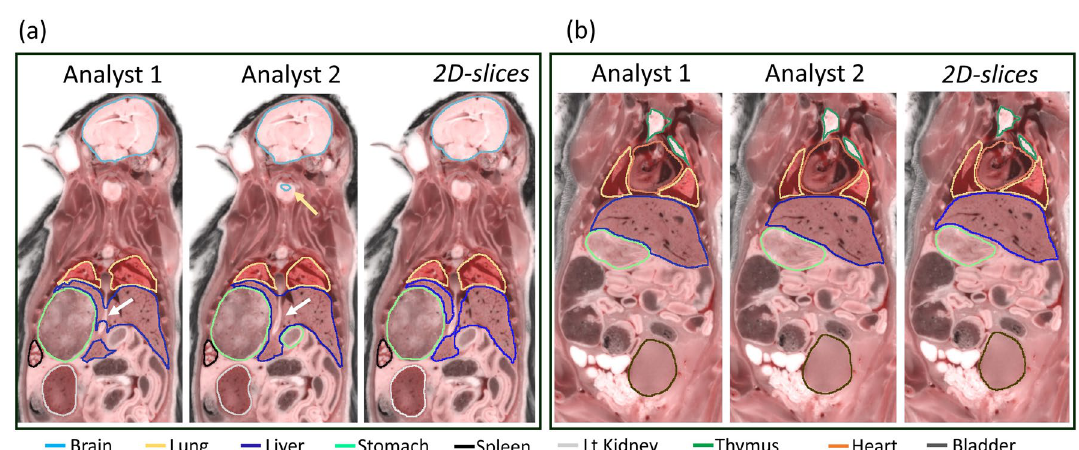
Figure 4. 2D visualization of segmentation results from the 2D-slices model and annotations from Analysts 1 and 2. Both analysts mistakenly included esophageal tissue (white arrows). Analyst 2 mistakenly labeled some spinal cord as brain (yellow arrow in ( a )). Good correspondence between the two analysts and the 2D-slices model is shown in ( b